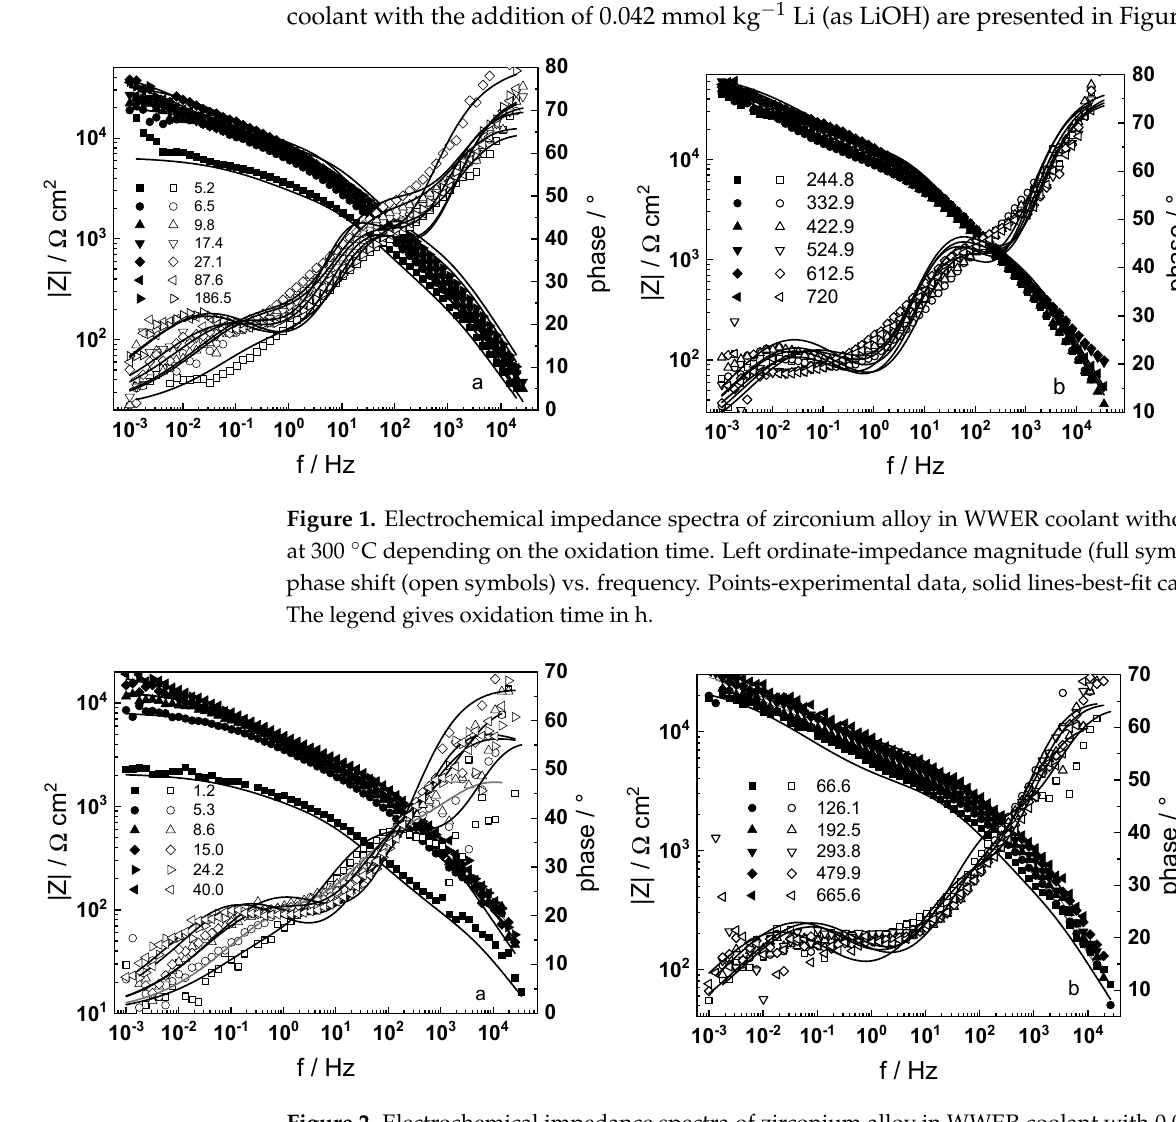
Figure 2. Electrochemical impedance spectra of zirconium alloy in WWER coolant with 0.042 mmol kg − 1 Li (as LiOH) at 300 °C depending on the oxidation time. Left ordinate-impedance magnitude (full symbols) and phase shift (open symbols) vs. frequency. Points-experimental data, solid lines- best-fit calculation. The legend gives oxidation time in h.